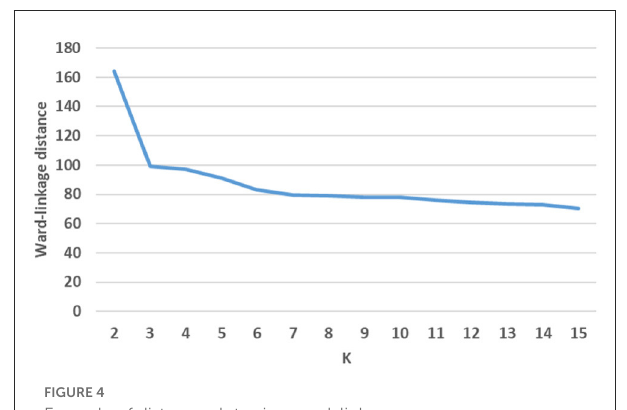
FIGURE4 Example of distance plot using